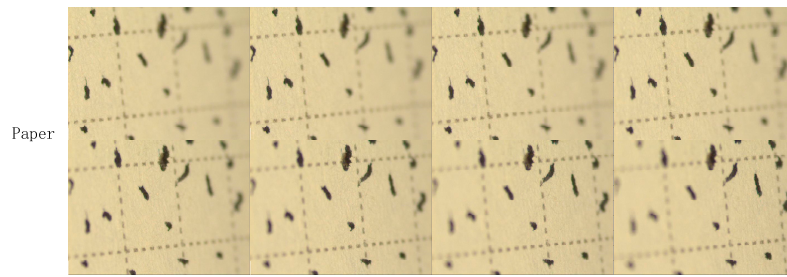
Figure 8. Registered defocused image sequence: paper (partial).